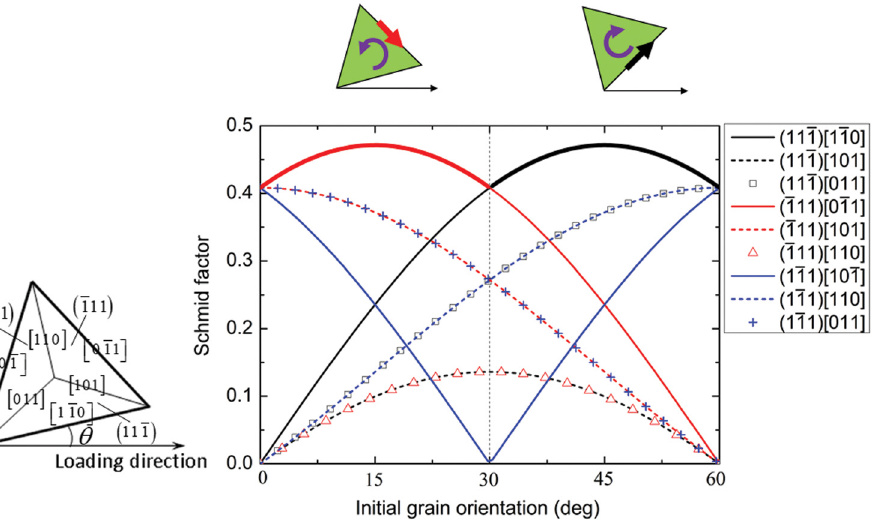
Figure 7: Dependence of the Schmid factor on the initial grain orientation for the 9 slip systems that have nonzero Schmid factor